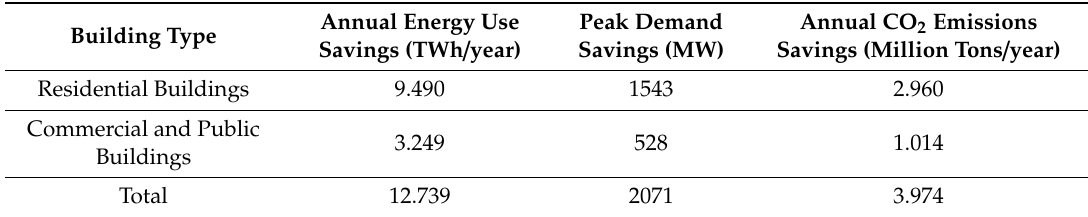
Table 21. Economic and environmental benefits for implementing integrated BEECs for all new buildings in the Arab